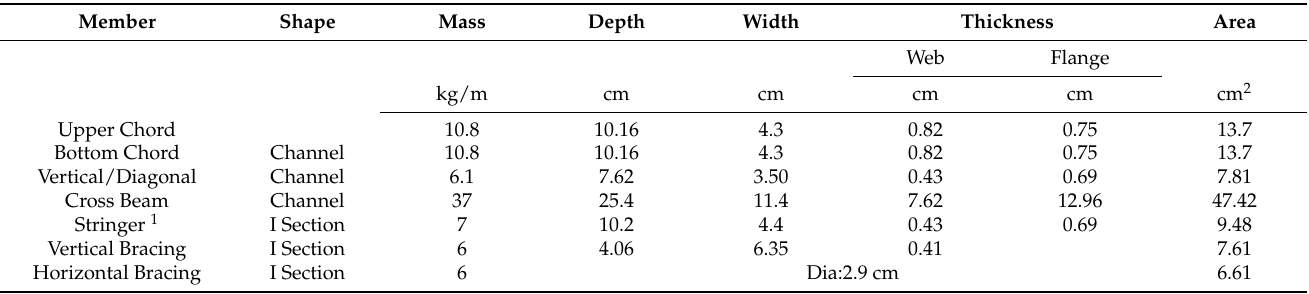
Table 2. Bailey bridge member sections.